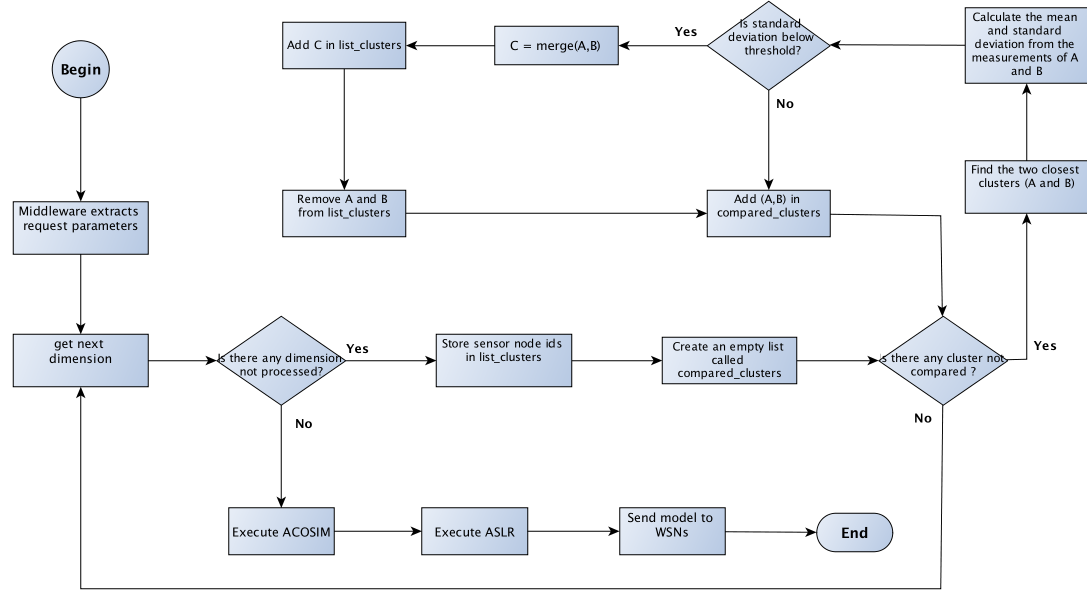
Figure 5. ACASIMv2 basic operation flowchart.